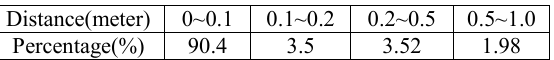
Figure 7. Comparison result of robot system & VZ400 point clouds in the indoor scene